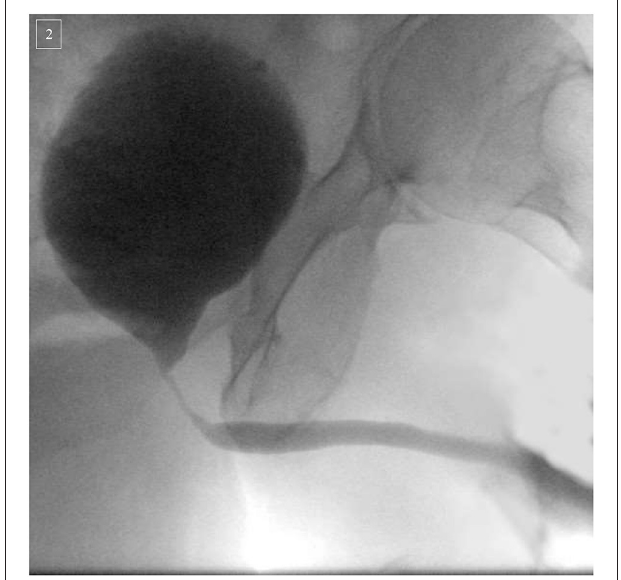
FIGURE 2 | Micturition-cystourography of a 74-year-old patient suffering of an infra/intersphincteric urethral stricture following robotic-assisted radical prostatectomy (2016) and adjuvant radiation (2017) therapy for prostate cancer. Urethroplasty with mucosal ventral-onlay graft was successfully